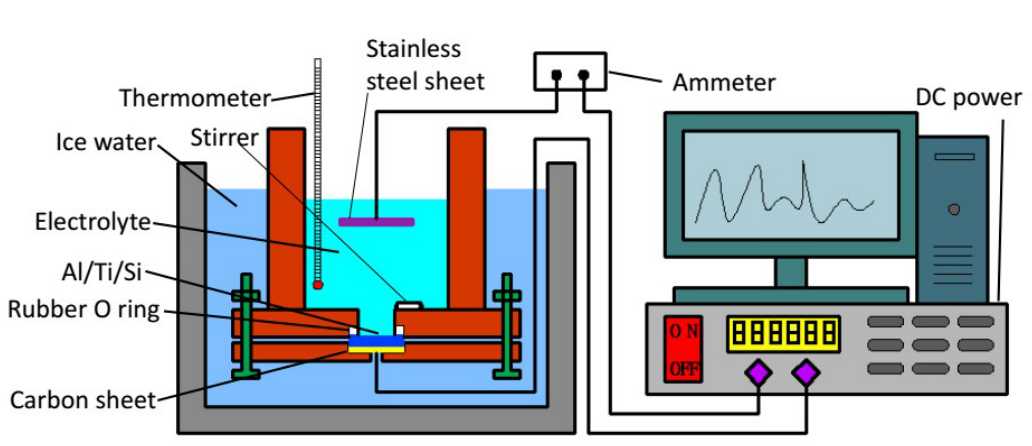
Figure 1. Schematic diagram of an anodizing device.